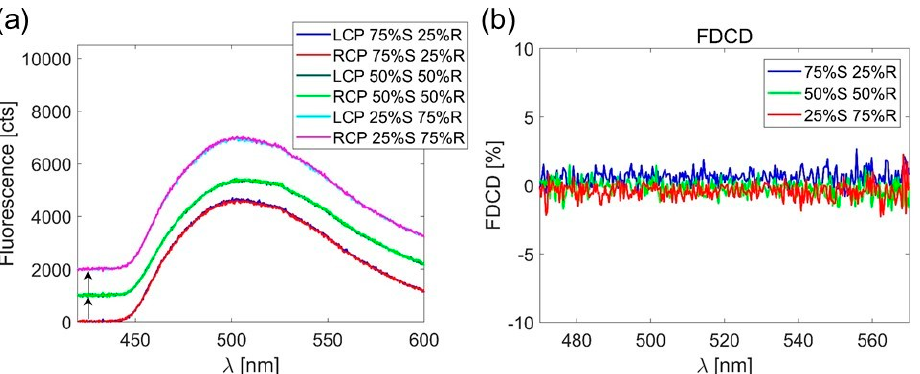
Figure 6 . ( a ) Fluorescence spectra of DMF solutions with relative enantiomer concentrations of 75% S /25% R (blue, red), 50% S /50% R (black, green), and 25% S /75% R (cyan, magenta), under LCP and RCP excitation. ( b ) FDCD spectra of the three solutions.